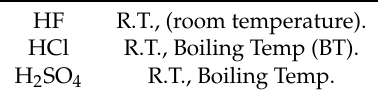
Table 2. The etching parameters for a single type of acid at different temperature. HF R.T., (room temperature).